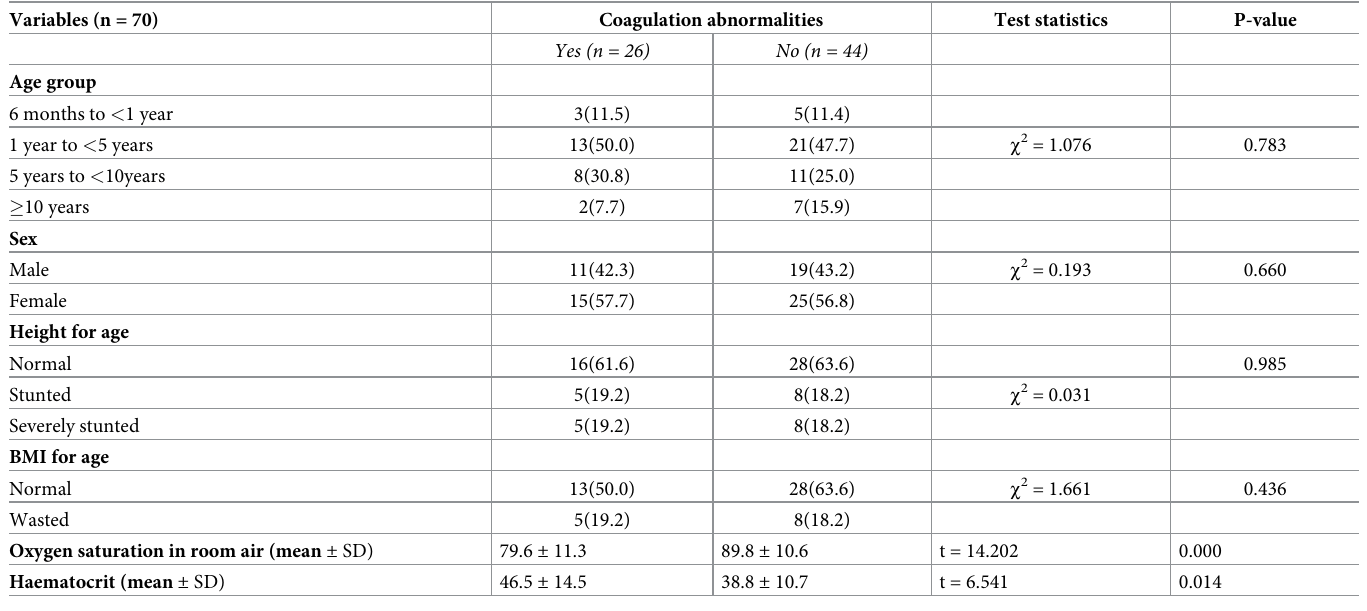
Table 6. Association between socio demographic characteristics, nutritional status and the prevalence of coagulation abnormalities in children with CHD.